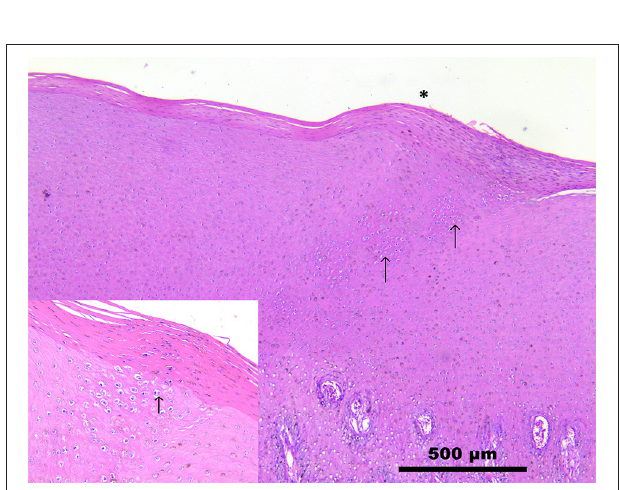
FIGURE 2 | Skin. Stenella coeruleoalba . (case 1). Mild increase in the thickness of stratum corneum (*), with hyperpigmentation and severe hydropic degeneration of keratinocytes (inset). Numerous round, up to 25 µ m, eosinophilic glassy structures (intracytoplasmic inclusion bodies)